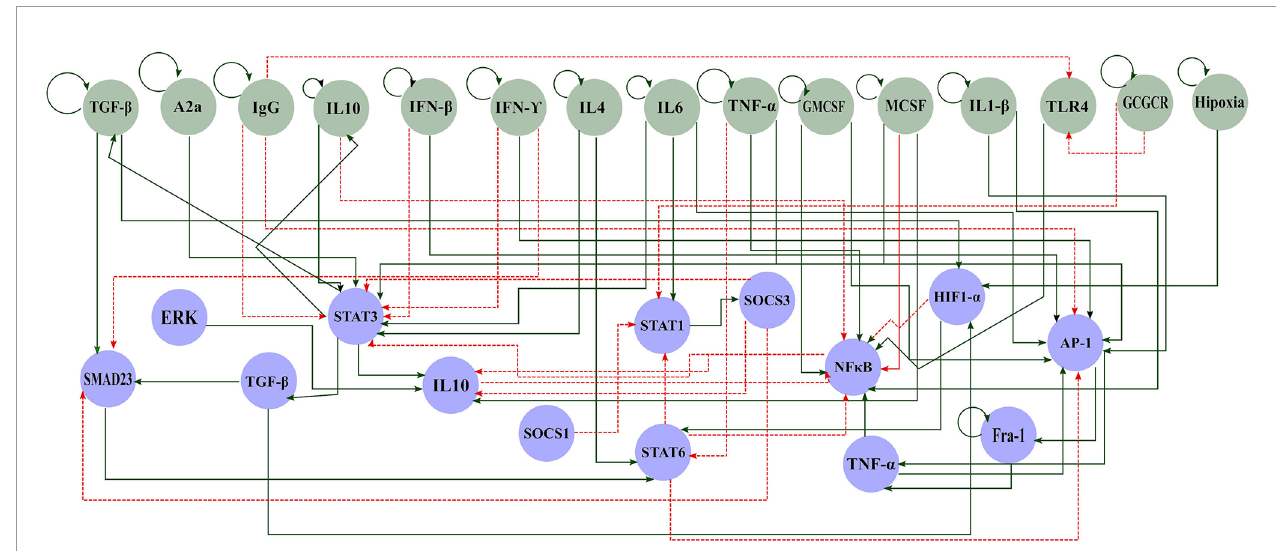
FIGURE 1 | Gene regulatory network of macrophage polarization in a tumor microenvironment. Green circles represent components of the extracellular space and blue circles represent the components of the internal machinery. Solid green arrows represent activation and dashed red arrows